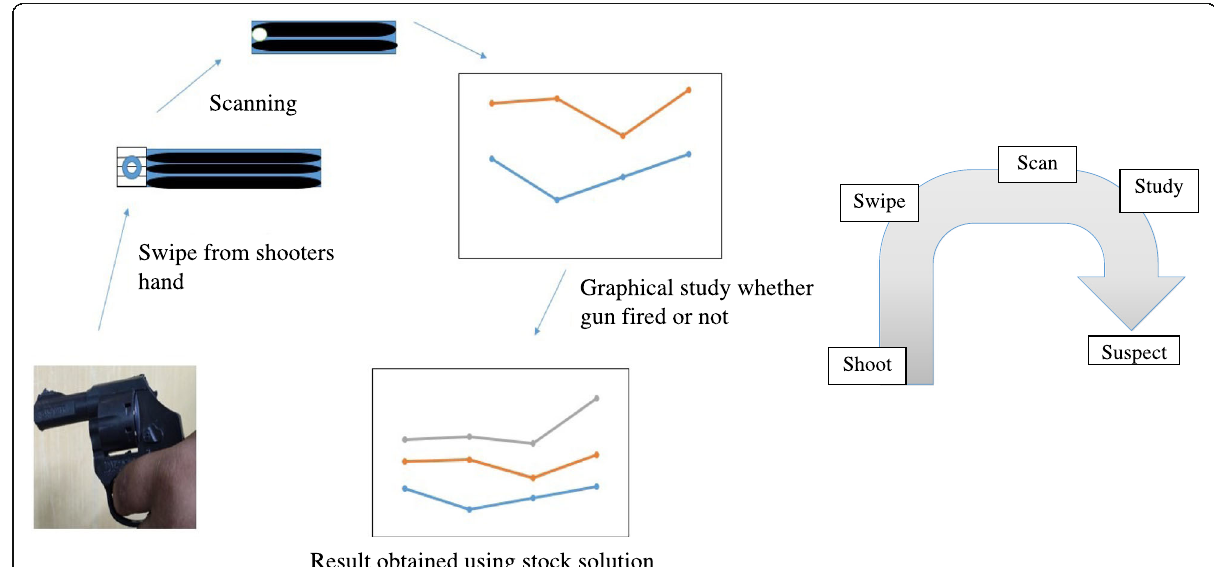
Fig. 6 Sequence of GSR analysis using ASV “ Swipe and Scan ” method. The Arrow Figure shows the Abrasive Stripping Voltammetry simplified method where firearm shoot, and Gunshot Particles were Swiped, Scanned and then studied whether firearm discharged or